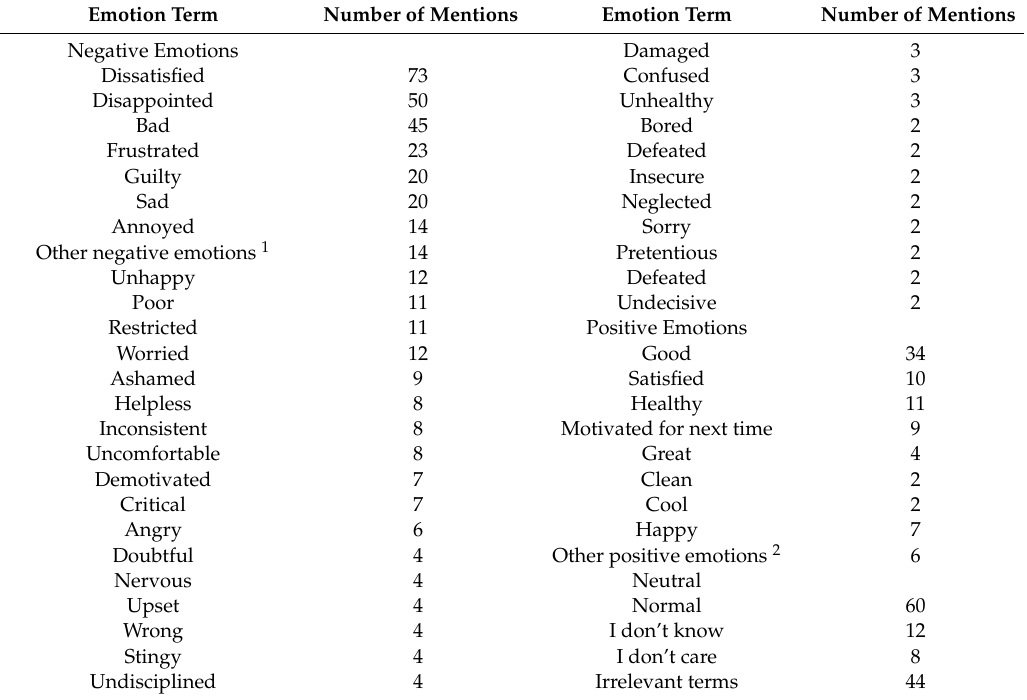
Table 12. Frequency of mention of the emotion terms that were reported by the participants when they were asked to state the first three emotions that come to their mind when they think of how the intention-behavior gap makes them feel.